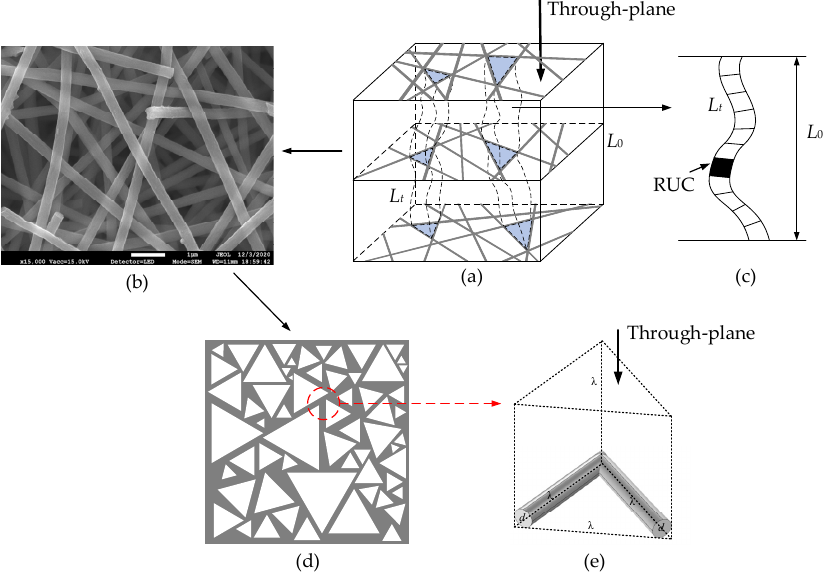
Figure 1. Pore-scale model: ( a ) 3D REV model; ( b ) SEM image; ( c ) flow capillary; ( d ) stochastic tri- angle pores; ( e ) equilateral triangle RUC model. triangle pores; ( e ) equilateral triangle RUC